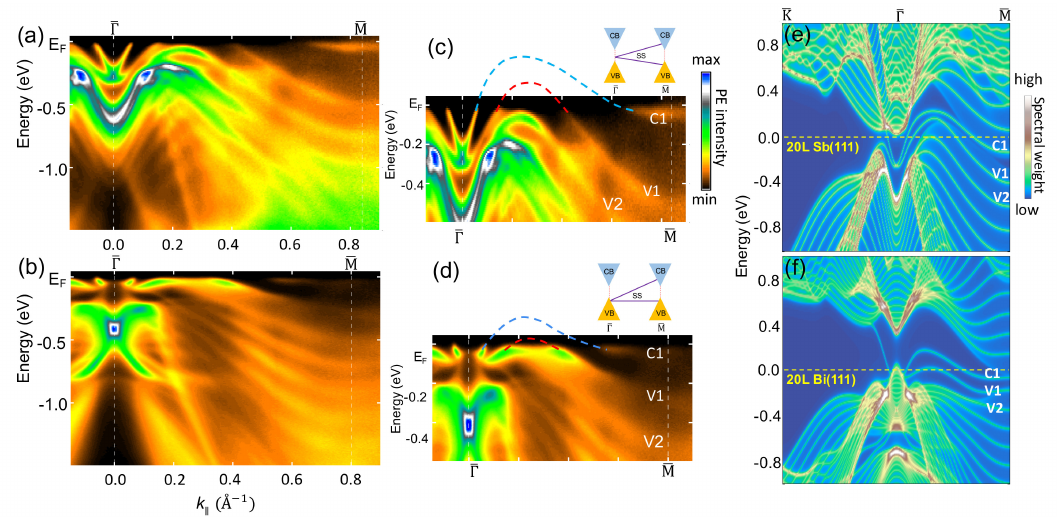
Figure 2. (Color online). ( a ) ARPES spectrum along Γ − M taken from a 20L Sb(111) film. ( b ) Same as ( a ) but from a 20L Bi(111) film. ( c , d ) Zoom-in spectra close to the Fermi level from ( a , b ), respectively. The dashed lines and schematic drawings show the connection of Rashba surface bands to quantum well conduction and valence subbands. ( e , f ) Calculated band structure of 20L Sb(111) and 20L Bi(111) slabs. The shaded areas indicate the projected bulk